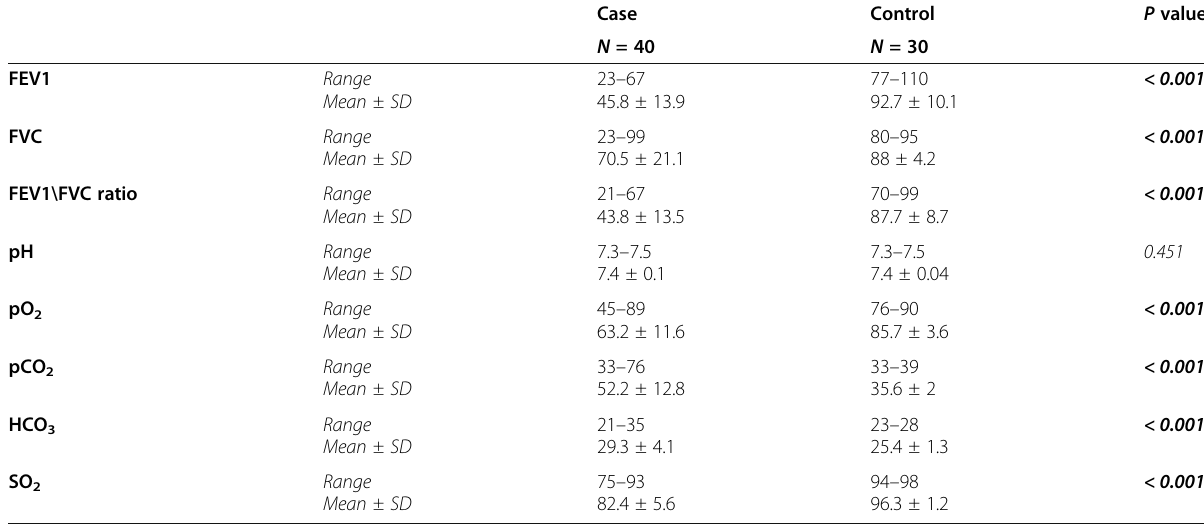
Table 2 Pulmonary functions and arterial blood gasses of studied